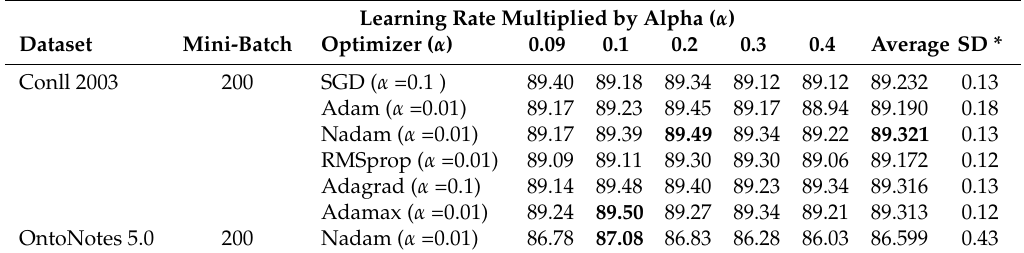
Table A1. Five times F1 scores of the optimizer, in this case SGD, Adam, Nadam, RMSprop, Adagrad, and Adamax.